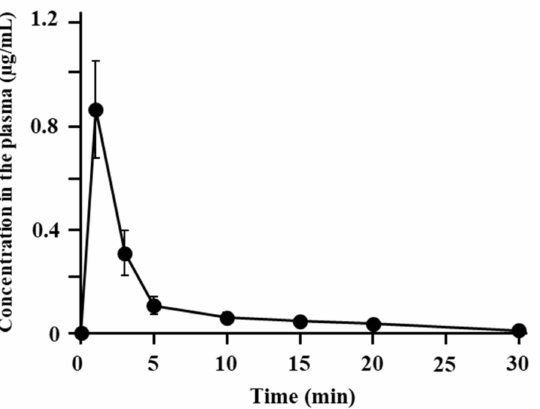
Figure 2. Concentration profile of ANA-TA9 in the plasma after nasal administration. The results are expressed as the mean ± SE of three